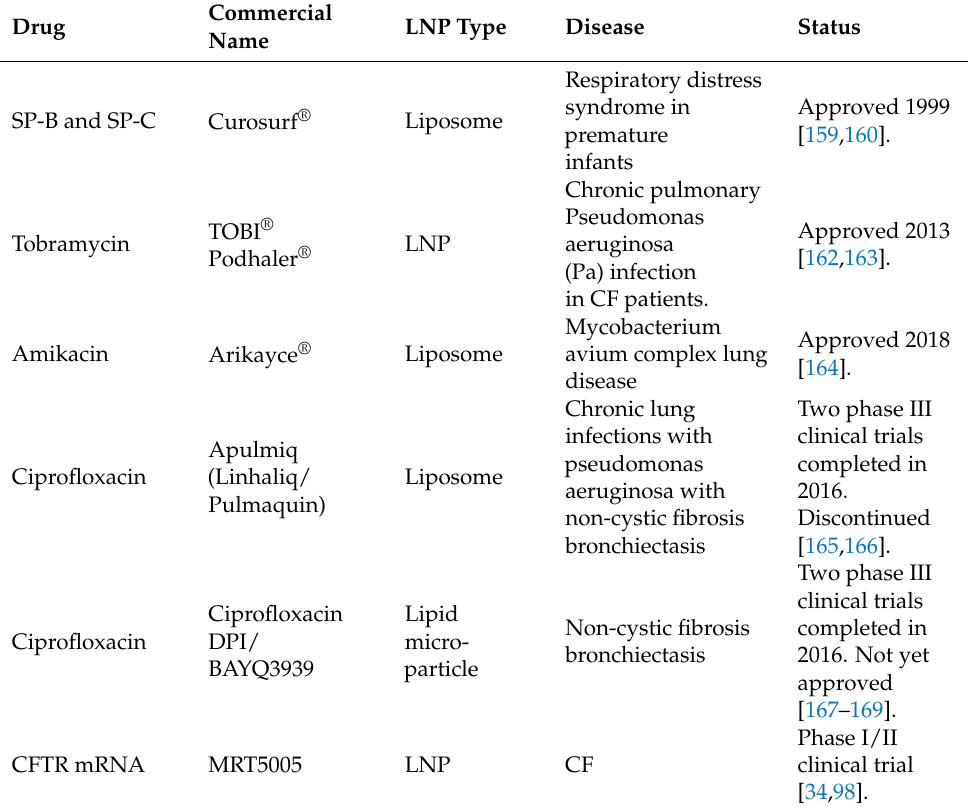
Table 2. Inhaled or pulmonary delivered LNP drugs approved and in clinical